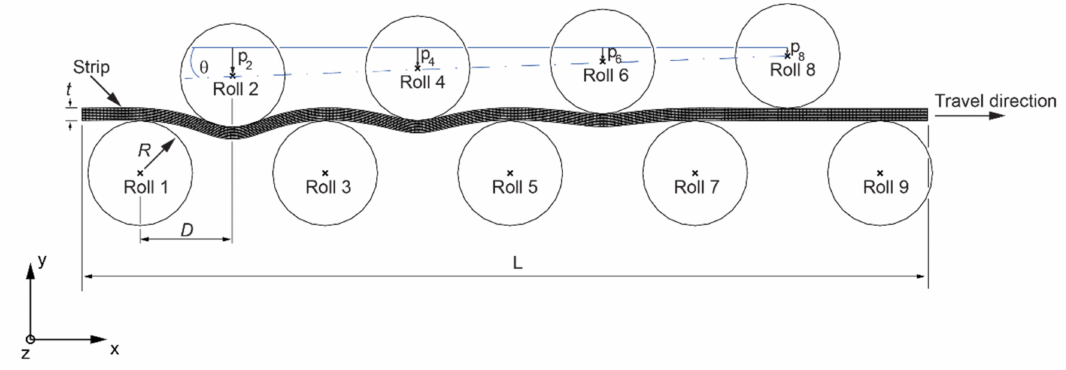
Figure 1. A schematic of a nine-roll